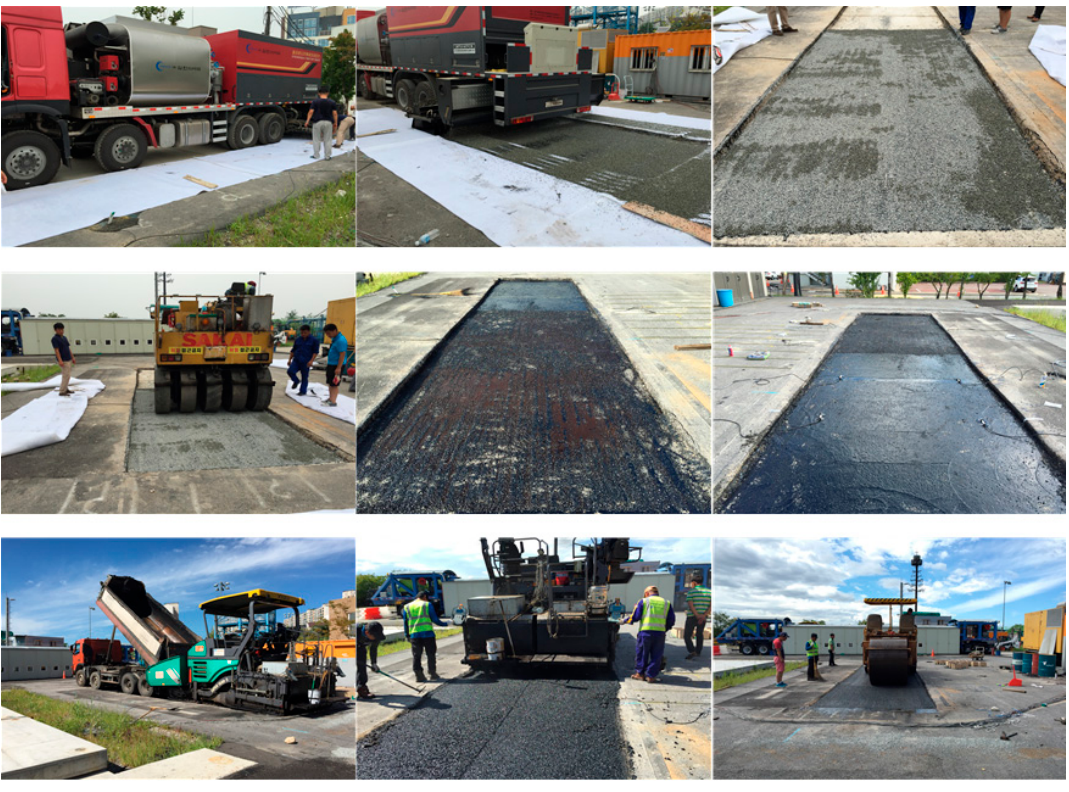
Figure 9. Construction for test section: upper layer.